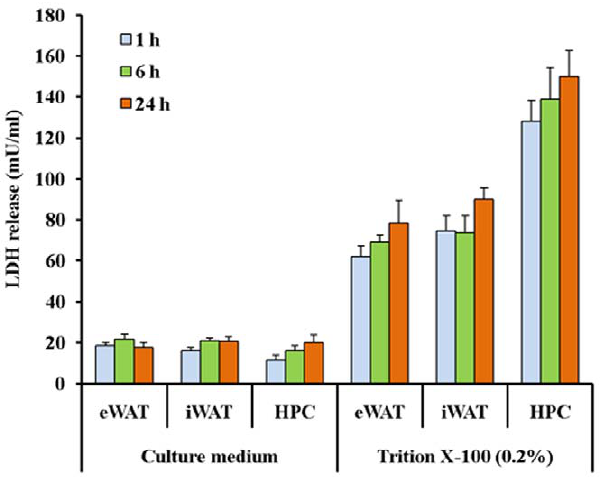
Figure 1. Cellular viability of primary hepatocytes and explants of epididymal adipose tissue (eWAT) and inguinal adipose tissue (iWAT) during 24 h culture. Culture medium containing Trition X-100 (0.2%) was used as a positive